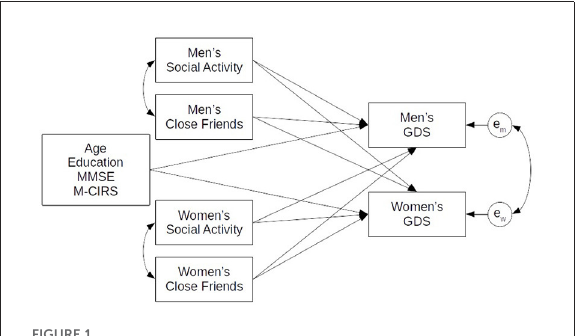
FIGURE1 APIM model of social factors and physical health on depressive symptoms.